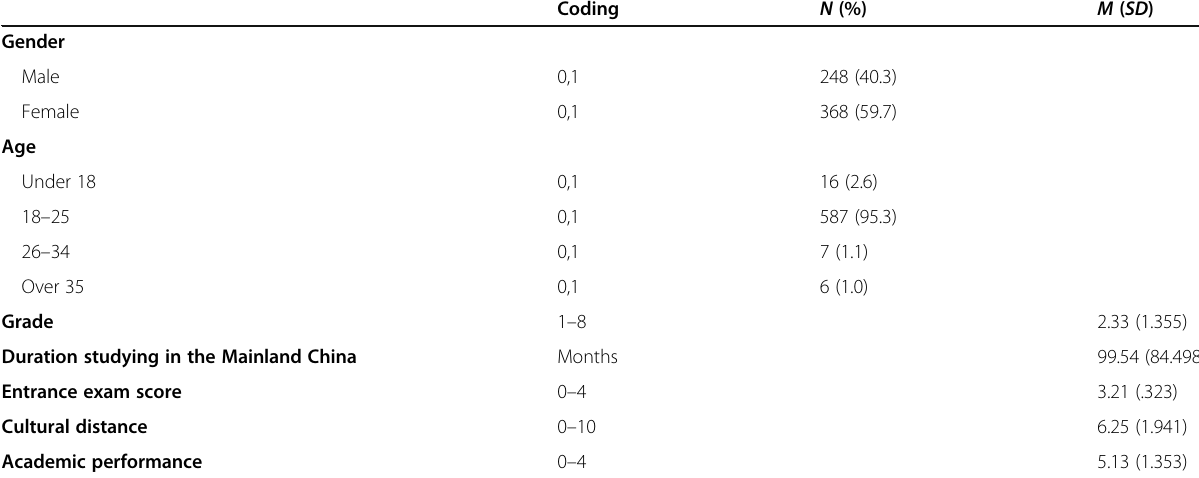
Table 1 Personal characteristics ( N = 616)